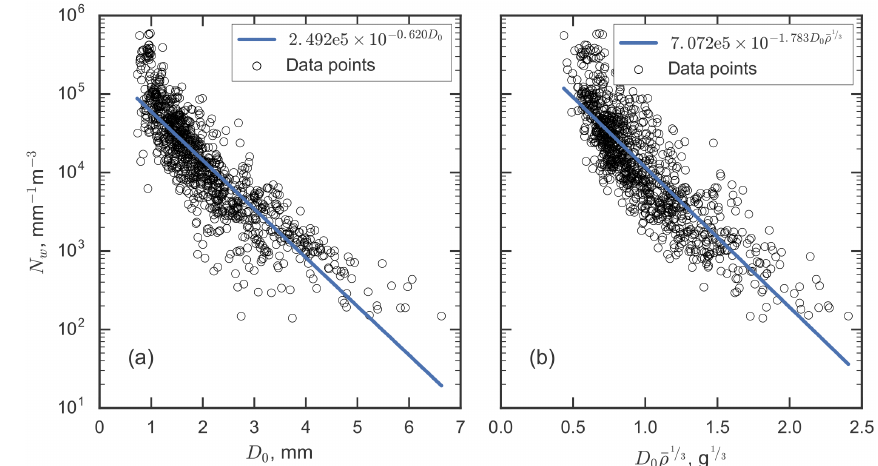
Figure 14. ( D 0 , N w ) and ( D 0 ρ 1 / 3 , N w ) with fitted relations.